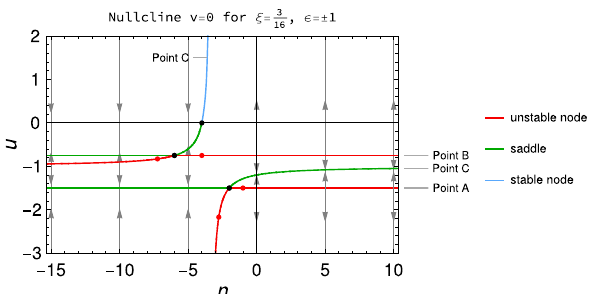
Fig. 6 Bifurcation diagram of the local stability of equilibrium points of system (25) on the v = 0 nullcline under variation of the parameter n for fixed ξ = 3 and ε = ± 1. Black dots in this diagram denote 16 a non-hyperbolic equilibrium point, while red dots denote an unstable proper node. Grey arrows show the direction of the flow on the nullcline